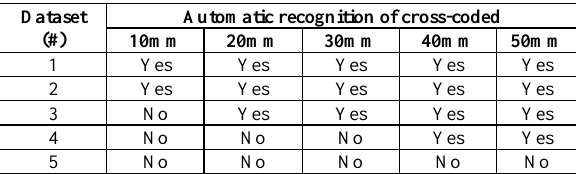
Table 6. Automatic code recognition using cross-coded target